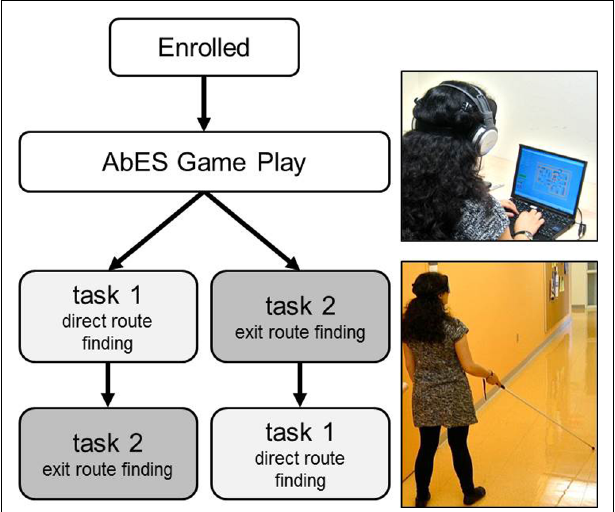
FIGURE 2 | Study Design. Once enrolled, all eligible participants underwent the same training and game play period. Following game play, two navigation assessments (10 trials each) were carried out and the order of assessment was randomized across